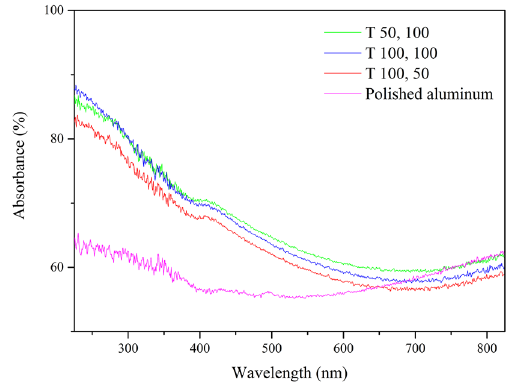
Figure 8. UV-Vis absorption spectrum for samples T and